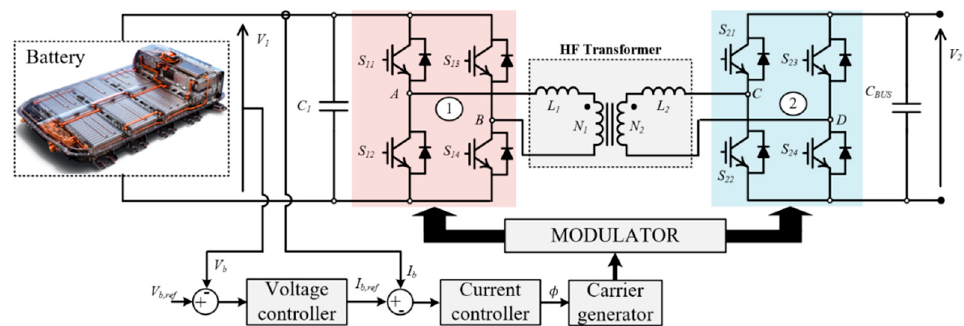
Figure 11. Block scheme of the Dual Active Bridge (DAB) control algorithm devote to regulate the charging of onboard batteries.